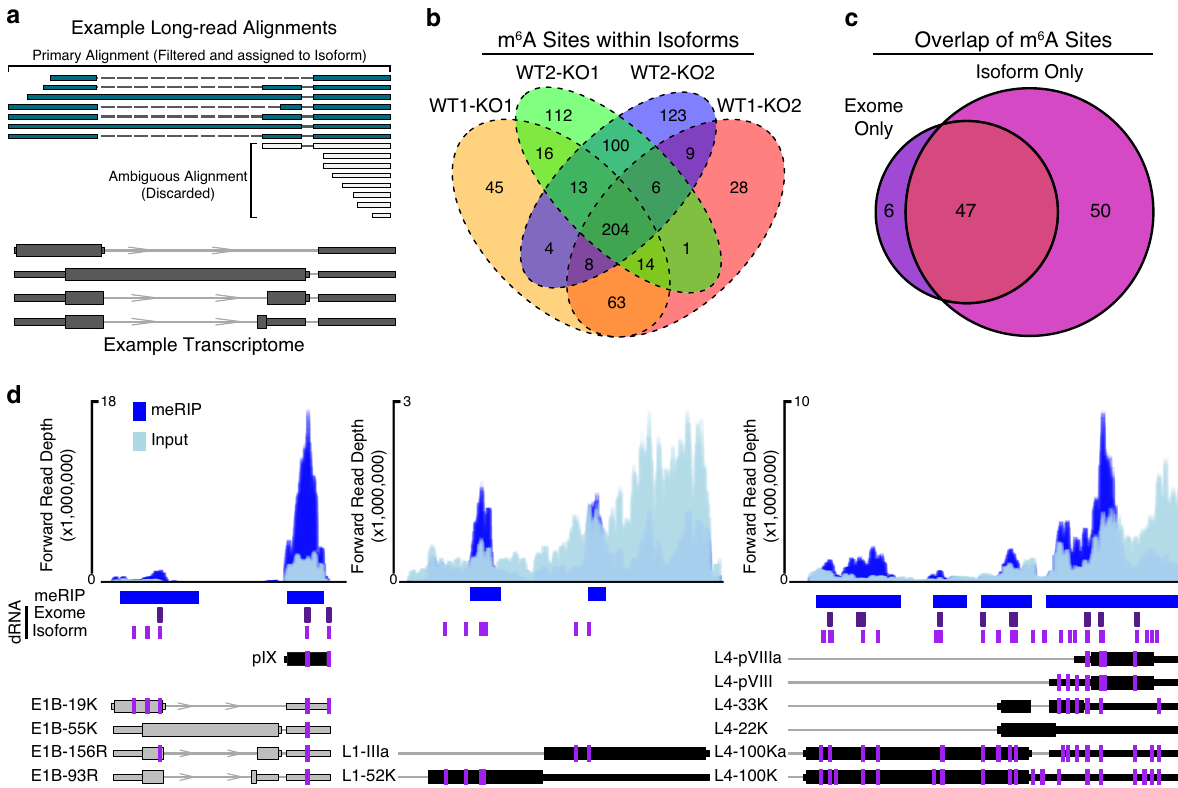
Fig. 4 Exome versus isoform-level m 6 A analysis. a Example of read fi ltering. Overlapping RNA isoforms are shown in dark gray. Sequence reads that map unambiguously (teal) are fi ltered and retained for m 6 A analysis. Sequence reads with multiple primary alignments (gray) are discarded if no single alignment is considered superior. b Isoform-level comparisons between WT and M3KO datasets yields 747 candidates (post-collapse) of which 204 are consistently detected across all four comparisons. c Overlap of all m 6 A sites detected in 4/4 exome-mapped replicates and 4/4 isoform-mapped replicates. Isoform only candidates were collapsed to unique genomic loci. d Representative plots showing isoform-speci fi c m 6 A predictions on adenovirus transcripts. MACS2 peaks and meRIP-seq signal (blue) is shown on top. Direct RNA (dRNA) predicted m 6 A sites at the exome-level (purple) or isoform- level (magenta) are shown below meRIP peaks as vertical lines. The positioning of m 6 A within individual viral transcripts from Fig. 2 are shown as magenta lines. Transcript names are shown to the left of each